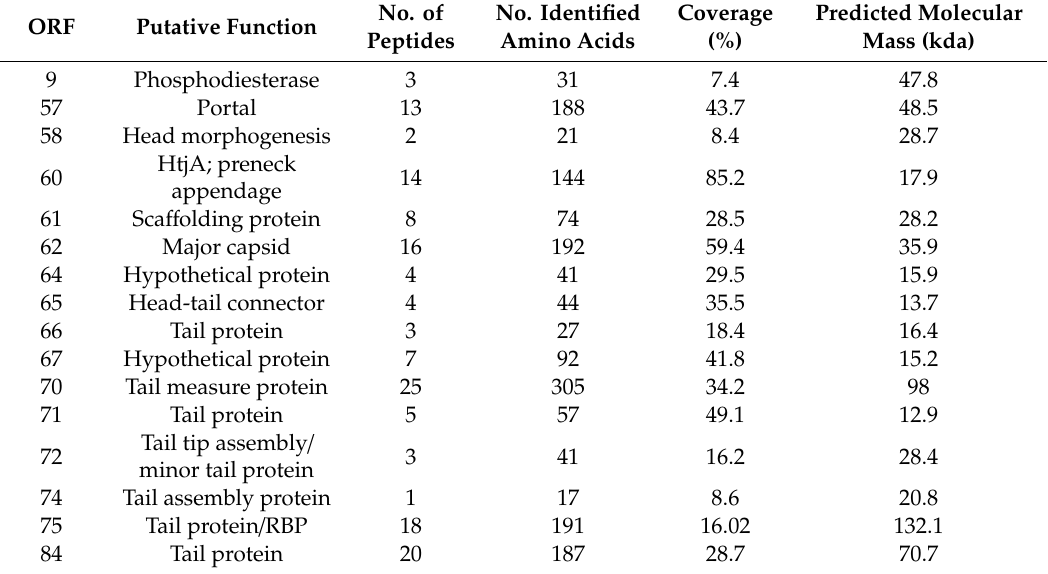
Table 4. JK16 Phage proteins as identified by ESI-MS / MS; putative functions were estimated using HMMER, BLASTp or HHpred. The threshold was at least 2 single independent peptides or 5% coverage value. The no. of peptides identifying the proteins and the% coverage of the proteins as well as the predicted molecular mass of the proteins and the no. of their component amino acids identified are presented